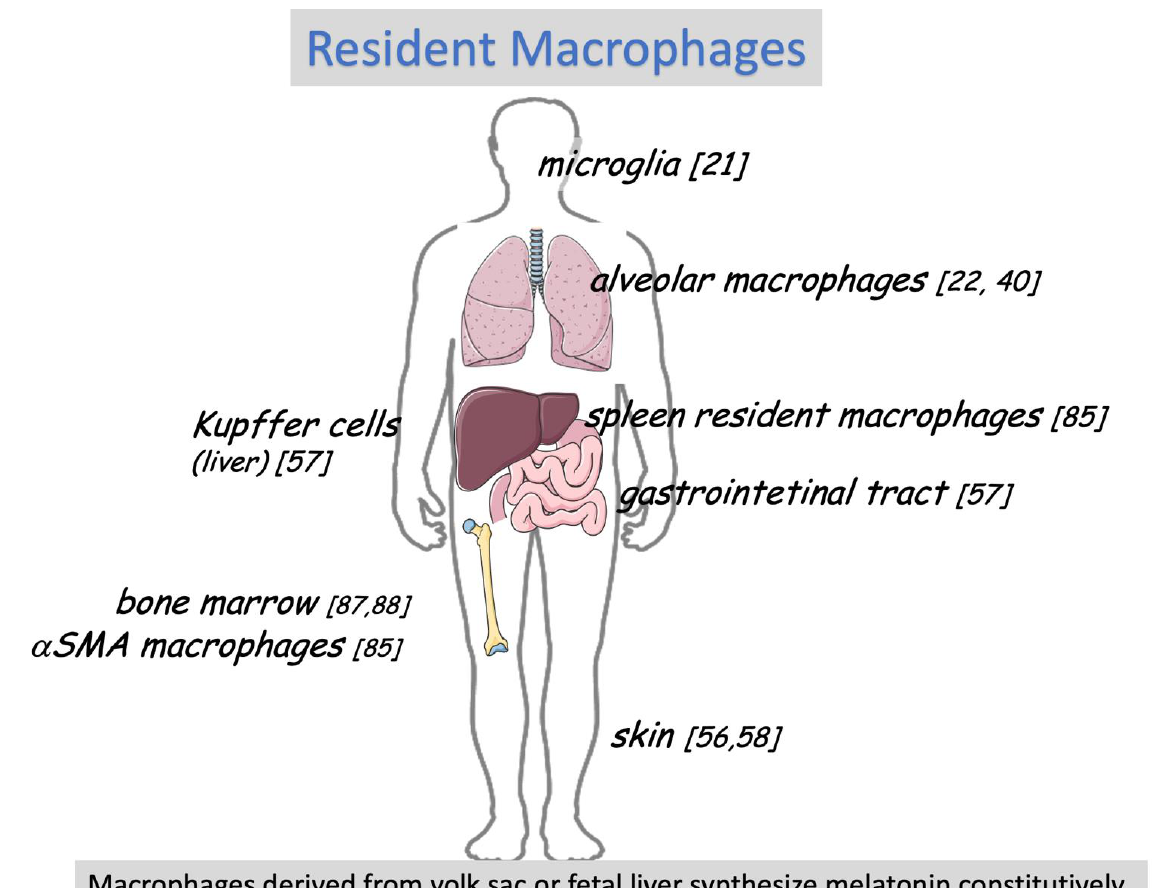
Figure 3. Tissue-resident macrophages and melatonin production—resident macrophages respond to the first defense line against PAMPs and DAMPs. These cells are phenotypically adapted to each tissue and, in most cases, impair the mounting of innate immune responses. All the cells listed above synthesize melatonin. Although the physiological role of tissue-resident macrophages is not yet disclosed in many tissues, in some tissues, as in the bone marrow (BM), it is essential for maintaining a reserve of long-lasting hematopoietic stem cells (see the text).